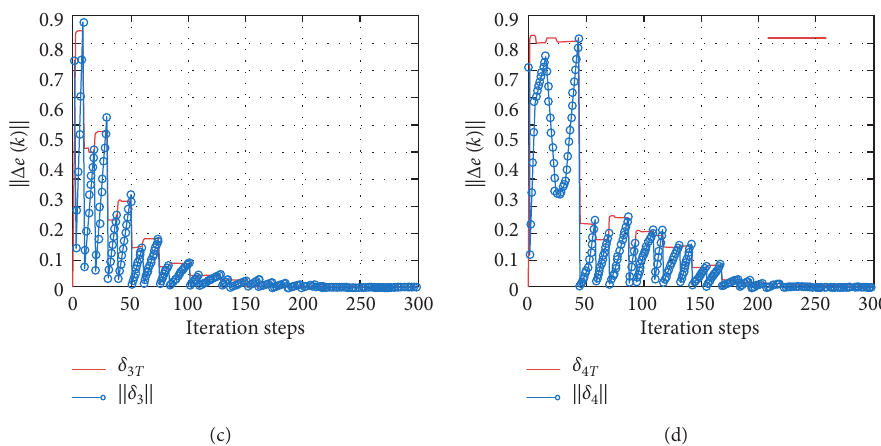
Figure 5: Comparisons of event-triggered errors and thresholds for every agent in the system. (a) Comparisons of event-triggered errors and thresholds for agent1. (b) Comparisons of event-triggered errors and thresholds for agent2. (c) Comparisons of event-triggered errors and thresholds for agent3. (d) Comparisons of event-triggered errors and thresholds for agent4.